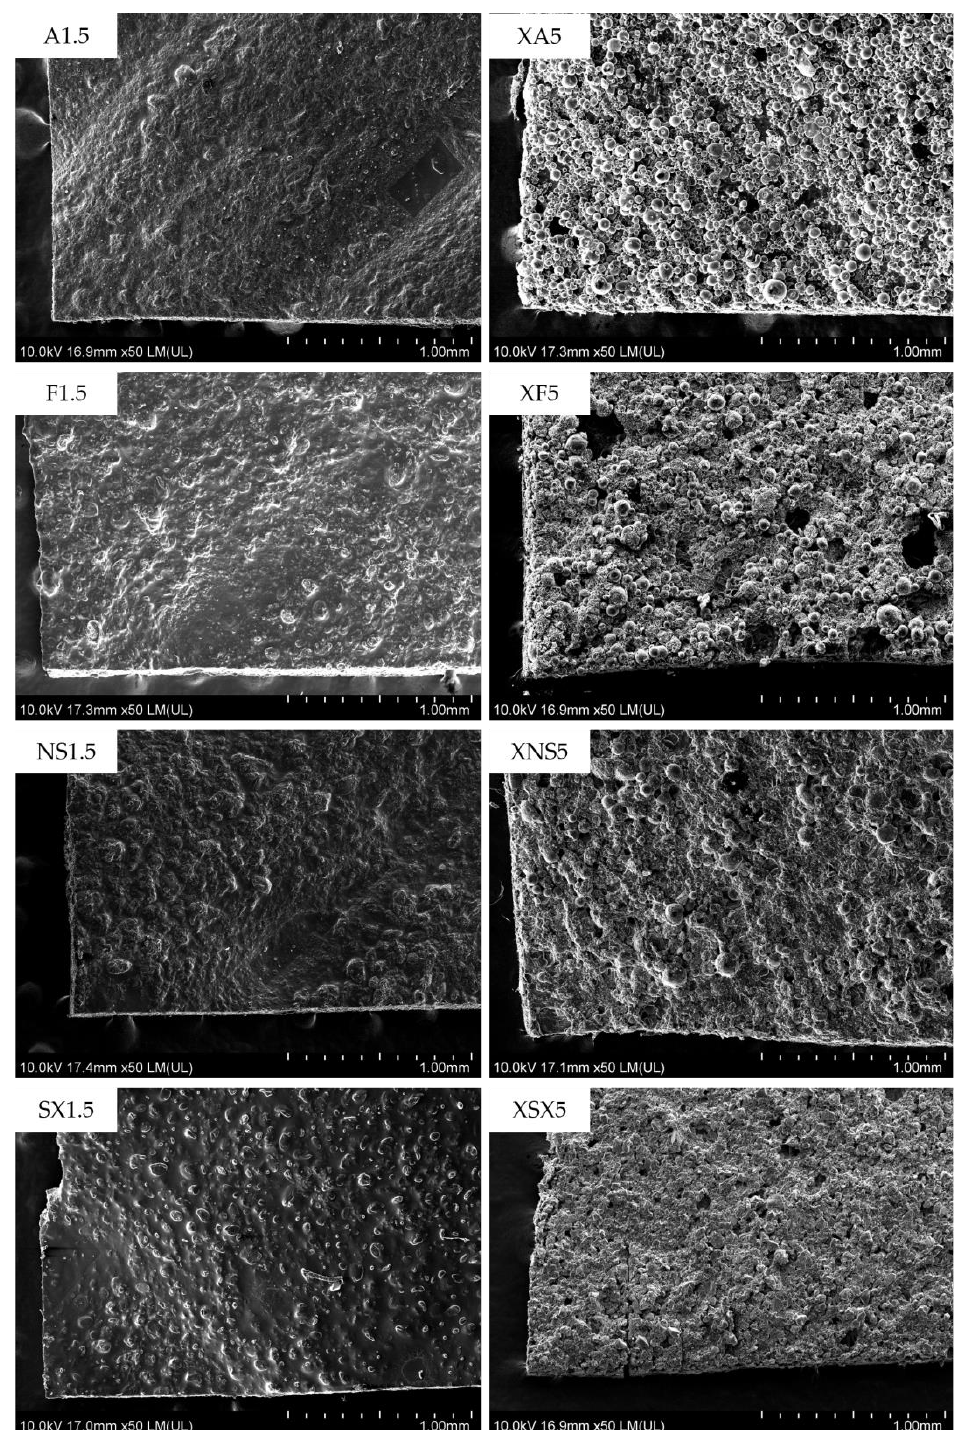
Figure 4. SEM images of selected ODFs: left — type A samples; right — type B samples.